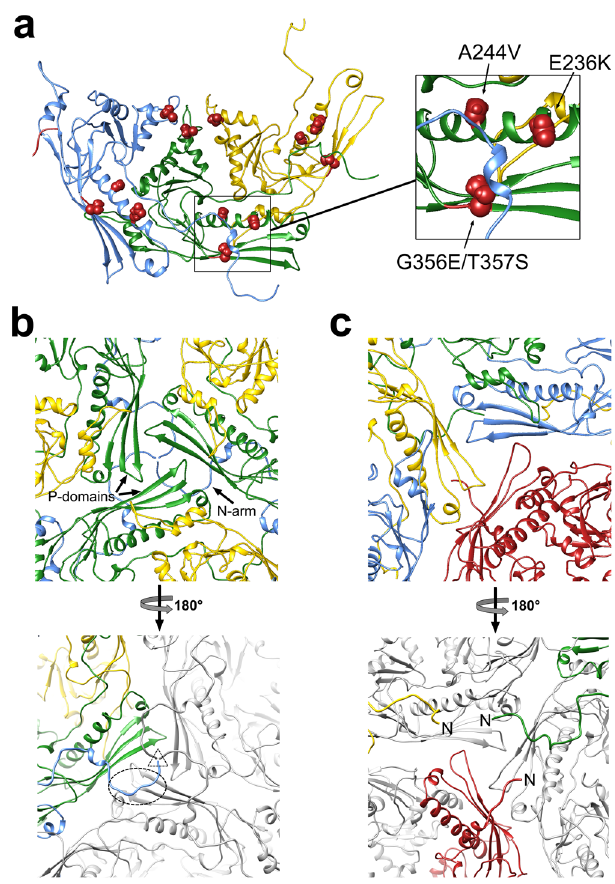
Fig. 7 Interactions between subunits. a Ribbon diagram of the CP hexamer subunits B (blue), C (green), and D (yellow), viewed from the inside of the shell, showing the location of sir mutations (space- fi lling representation). The inset shows a close-up view of a B subunit N-arm (blue) interacting with the region where the sir residues are located in the adjacent C subunit (green). b Ribbon diagram showing the arrangement of subunits around the icosahedral threefold axis. The top panel is viewed from the outside of the shell, while the bottom panel is viewed from the inside. The P-domains from three C subunits (green) form a trivalent interaction. The N-arms of the B subunits (blue) reach across to interact with the C subunit in the adjacent capsomer (dashed oval outline) and come together in a triskelion (dashed triangle) at the threefold axis. c Ribbon diagram showing the subunits around the quasi-threefold axis between a pentamer and two hexamers, viewed from the outside (top) and from the inside (bottom). P-domains from the A (red), B (blue), and D (yellow) subunit form a trivalent interaction, but the N-arms do not form a